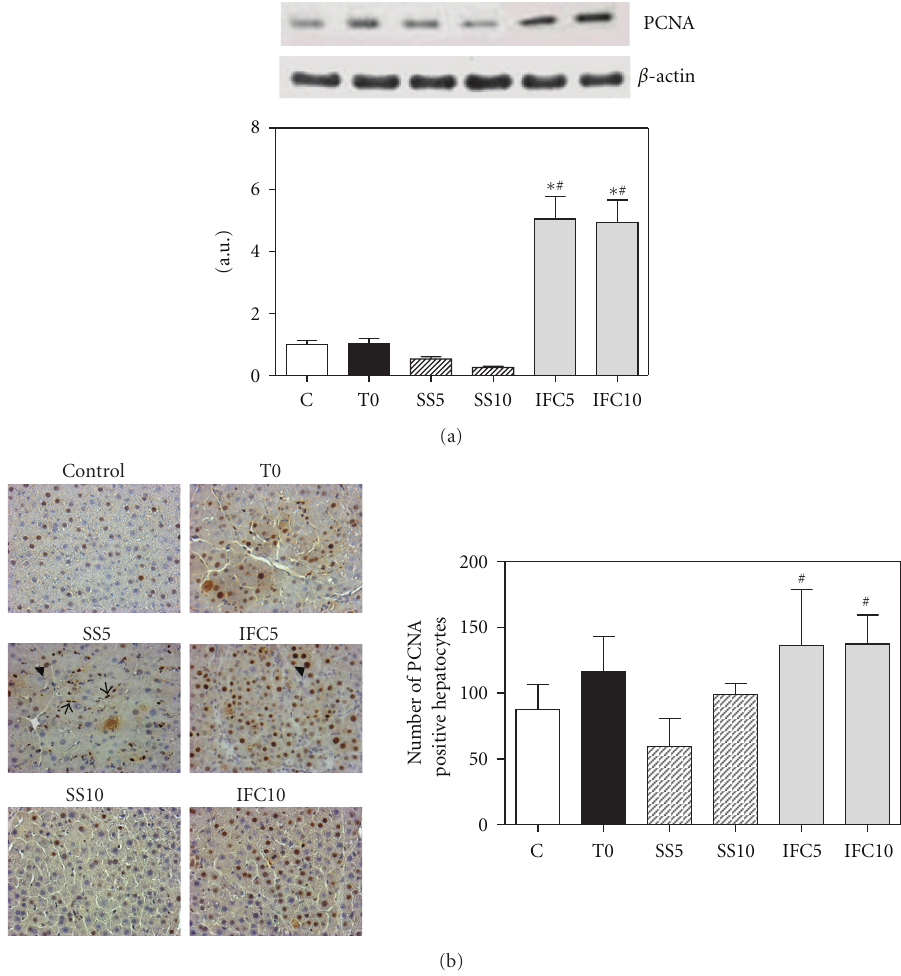
Figure 1: E ff ect of IFC305 treatment on the liver PCNA protein expression in CCl 4 -induced cirrhosis in rats. (a) Protein expression of PCNA and the house keeping gen β -actin from liver nuclear extracts was determined by western blot analysis. A representative western blot image is shown. The bar graph represents the densitometry analysis expressed as arbitrary units of the mean ± SEM from 3rats/group; values were normalized to β -actin immunodetection. (b) Immunohistochemical analysis of PCNA expression. Hepatocyte (arrowhead) and nonparenchymal cell (arrow) are marked. The number of PCNA positive hepatocytes was quantified as described in Section 2. ∗ Statistical di ff erence ( P < 0 . 01) when compared to C group. # Statistical di ff erence ( P < 0 . 01) when compared to their respective experimental group SS5 or